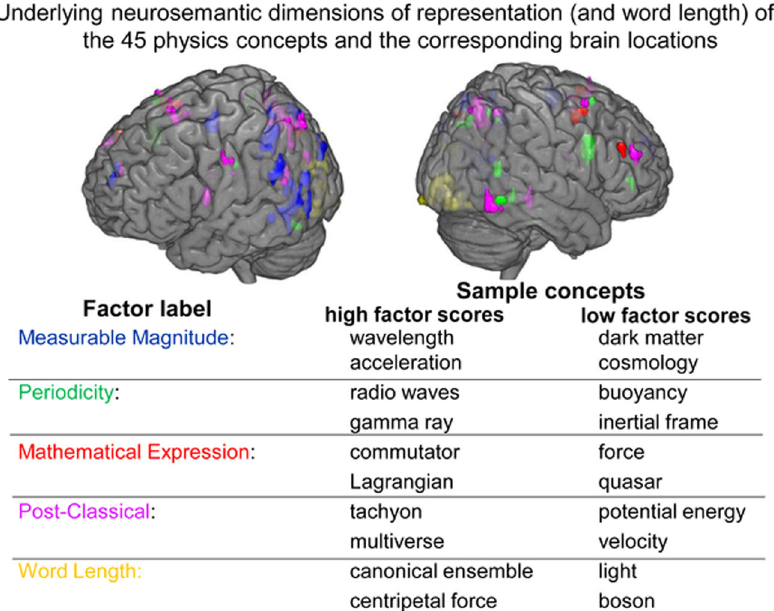
Fig. 6 Factor locations for the fi ve factors (35 voxel clusters) are depicted on a rendered brain. Colors differentiate the factors and greater color transparency indicates greater depth. Sample concepts from the two ends of the dimensions are listed. The post-classical factor locations include those whose activations were high for post-classical concepts (their locations are shown in Fig. 4) as well as those locations whose activations were high for classical